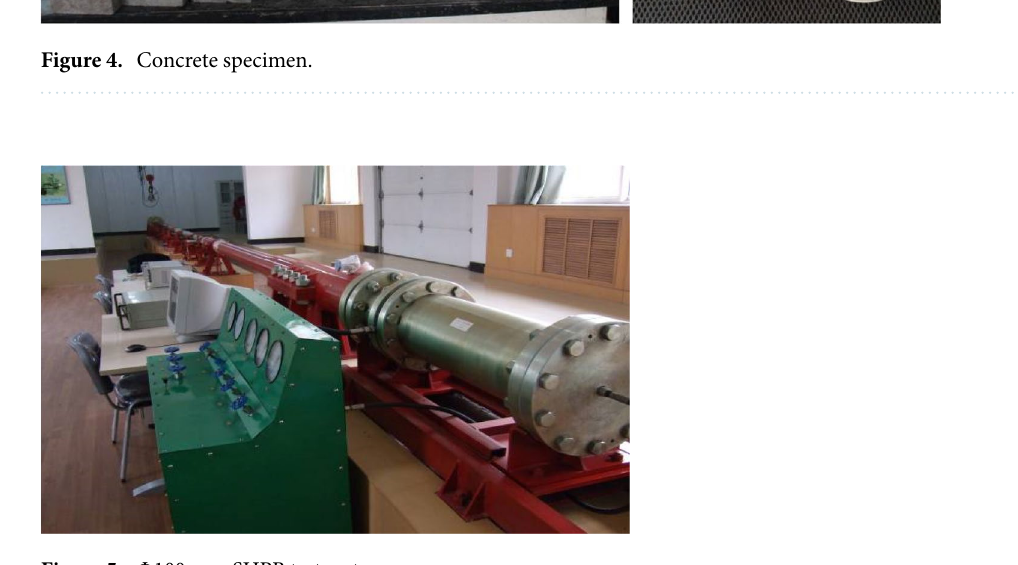
Figure 5. Φ100 mm SHPB test